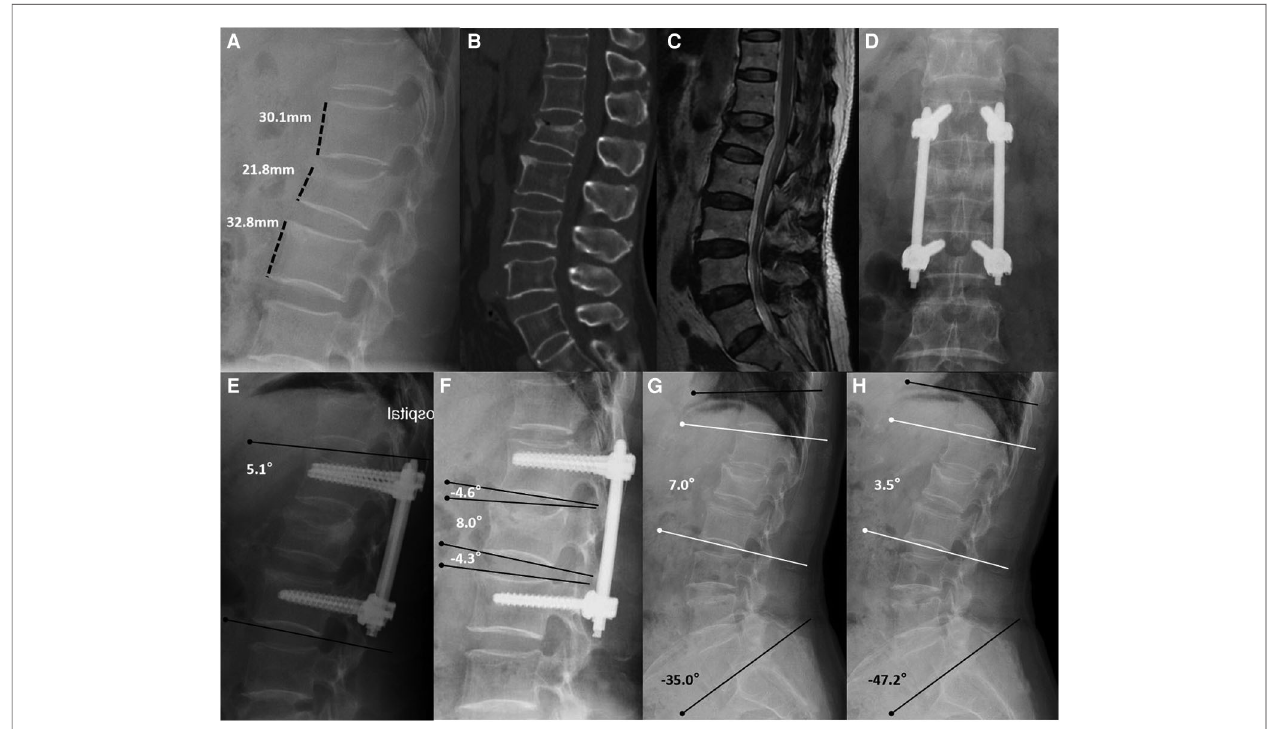
FIGURE 1 | Non-fusion fi xation using percutaneous pedicle screws for L1 fracture (type A3). A 67-year-old woman from group A presented in 2017 with lower back pain without neurological de fi cit after a fall. ( A – C ) Lateral radiography, sagittal computed tomography, and T-2 weighted magnetic resonance imaging were taken preoperatively. Anterior vertebral body-to-height ratio=21.8/[(30.1+32.8)/2]×100%=69.3%. ( D , E ) At the 1-month follow-up, anteroposterior and lateral radiographs show that the L1 vertebral body height had recovered, and the kyphotic angle had decreased (Cobb A=5.1°). ( F ) At the 1-year follow-up, lateral radiographs were taken before implant removal. Cobb B=8.0° and Cobb C=( − 4.6°)+( − 4.3°)= − 8.9°. ( G , H ) At the 40-month follow-up, fl exion and extension lateral radiographs show the motion range of the spine. Local motion range=7.0° – 3.5°=3.5° and total motion range=( − 35.0°) − ( −